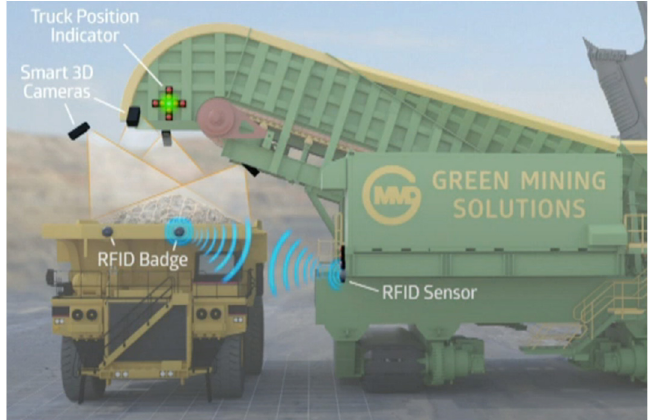
Figure 10. Sensor system [23].